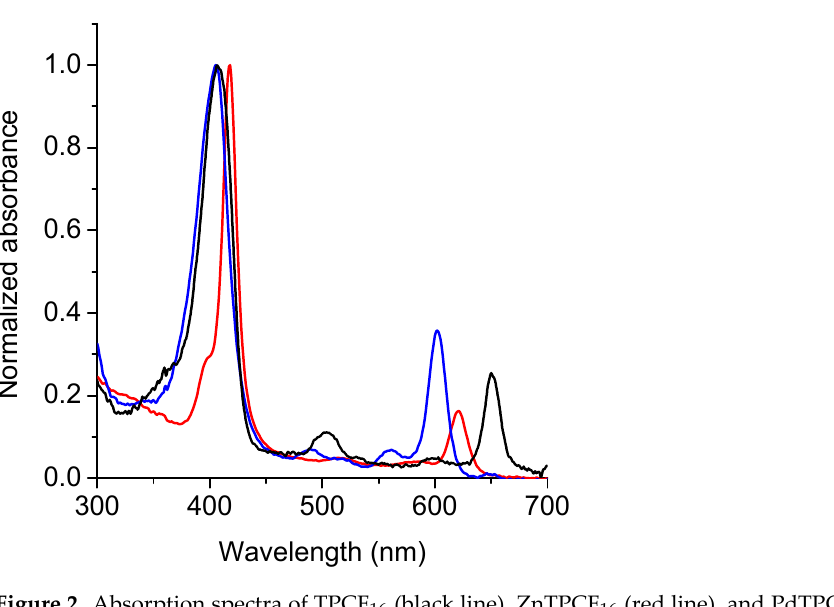
Figure 2. Absorption spectra of TPCF 16 (black line), ZnTPCF 16 (red line), and PdTPCF 16 (blue line) in DMF. Table 1. Spectroscopic characteristics of TPCF 16 , ZnTPCF 16 , and PdTPCF 16 in